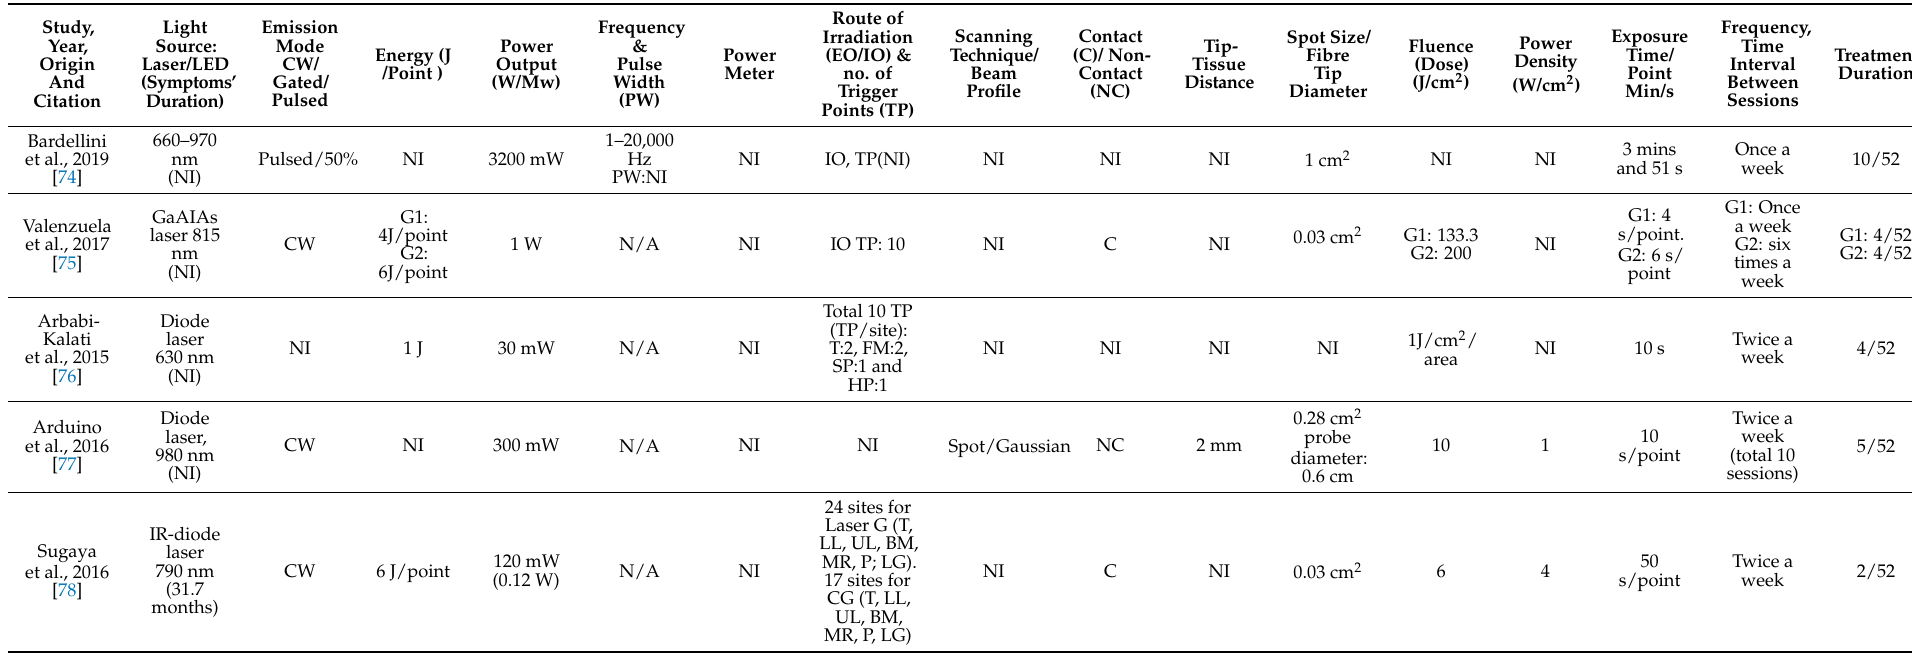
Table 3. Tabular representation of lasers/LEDs parameters utilised in the chosen eligible in vivo RCTs human studies related to burning mouth syndrome (BMS). Abbreviations: CW: continuous emission mode; TT: tip tongue; LT: lateral tongue; DT: dorsal tongue; BM: buccal mucosa; LAM: labial mucosa; HP: hard palate; SP: soft palate; G: gingivae; AM: